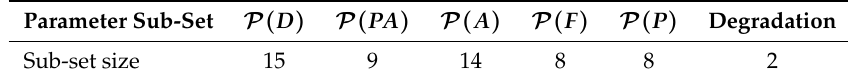
Table A1. Total number of parameters for each parameter set. The dependent parameter is (cid:101) DOM = 1 − (cid:101) DOC in the sub-set of A parameters P ( A ) . A Parameter Sub-Set P ( D ) P ( PA ) P ( A ) P ( F ) P ( P ) Degradation Sub-set size 15 9 14 8 8